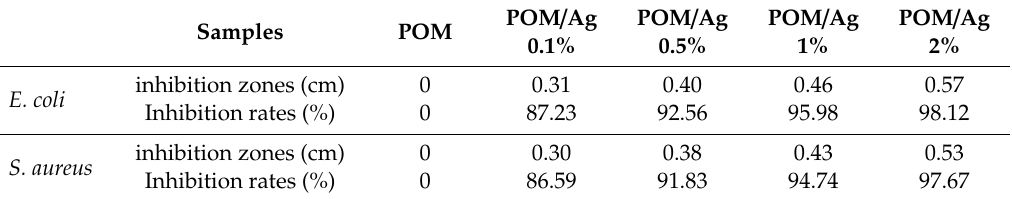
Figure 14. Optical images of the inhibition zones of POM/Ag nanocomposites against E. coli ( a – e ) and S. aureus ( A – E ). The inset scale bar is 2 cm. Table 7. The inhibition zones and inhibition rates of POM/Ag nanocomposites.